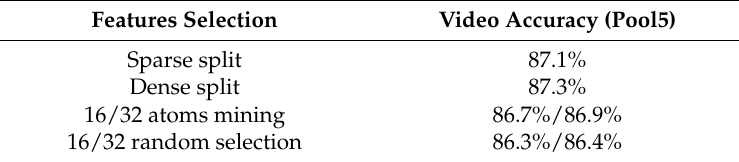
Figure 5. The mined atoms (S = 4) sorted by timestamps and their corresponding clips in the 8f temporal scale. Table 2. Comparison of the atoms mining with other methods in the RGB stream of 8f temporal scale on UCF101